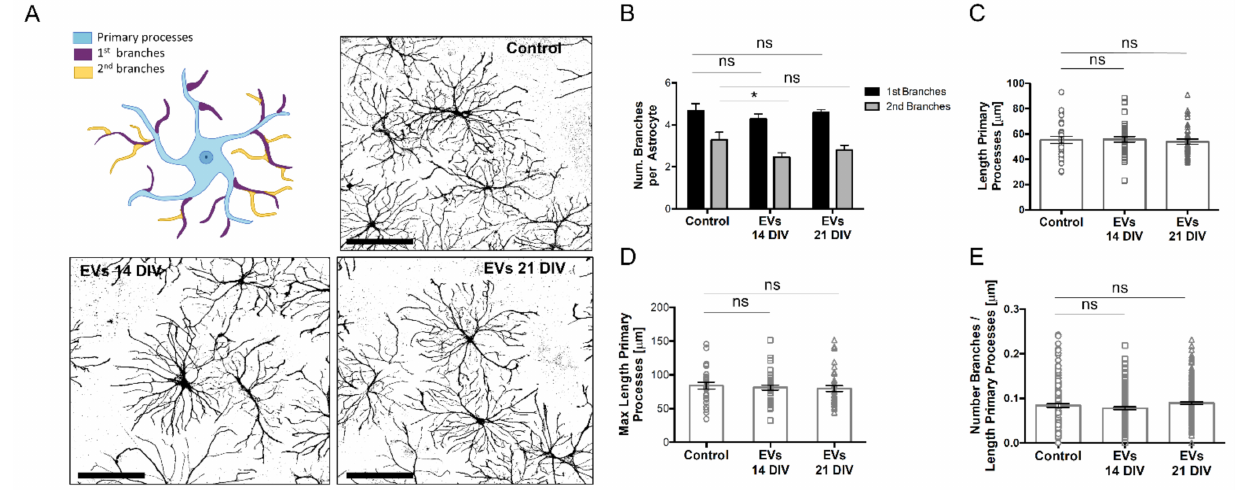
Figure 6. The levels of the astrocytic protein GFAP decrease after treatment with 14 DIV EVs. ( A ) Western blot analysis of microglial marker Iba1 and the astrocytic marker GFAP in 14 DIV neural culture lysates untreated (cnt) or treated for 24 h with EVs isolated from the media of 14 DIV or 21 DIV neural cultures. Actin was used as a loading control. ( B ) Plot comparing the levels of Iba1 quantified from Western blot experiments like the one shown in panel A (n = 4 independent experiments). ( C ) Plot comparing the levels of GFAP, quantified from Western blot experiments like the one shown in panel A (n = 5 independent experiments). All graphs show the mean protein levels relative to the untreated (control) condition ± SEM. Statistical significance was analyzed by one-way ANOVA. Tuckey’s Multiple Comparison Test was used for post hoc analysis (** p < 0.01, *** p < 0.001, ns = non-significant).